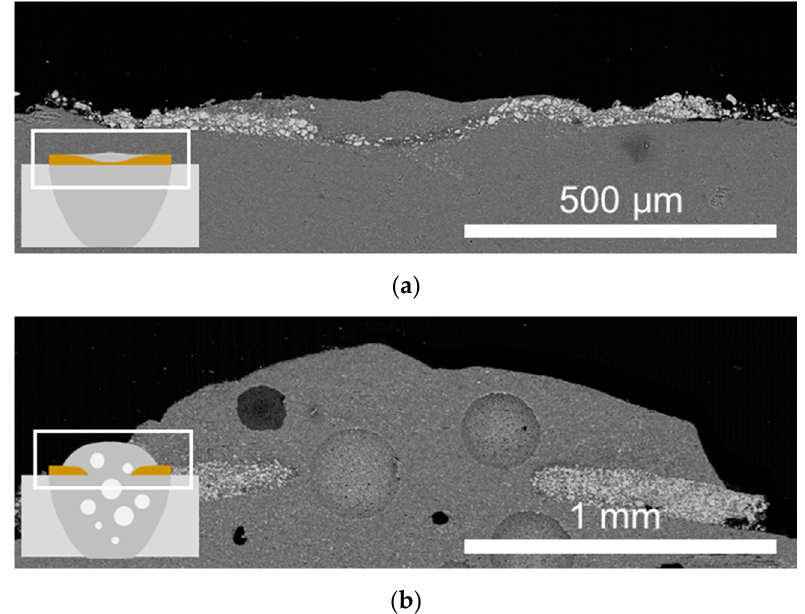
Figure 7. FE-SEM images show the laser-irradiated top part under process parameters of ( a ) 1 kW, 12 12 mm / s and ( b ) 2 kW, 24 mm / s. Insets on the left are a schematic view of the cross-section of the mm/s and ( b ) 2 kW, 24 mm/s. Insets on the left are a schematic view of the cross-section of the welds.